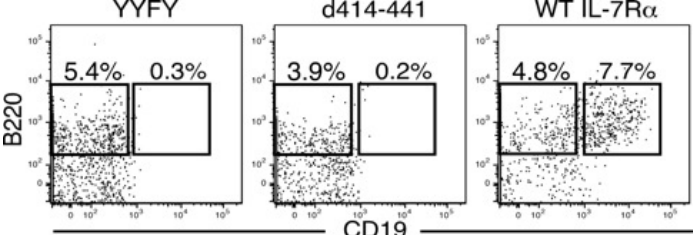
Figure 2. The d414–441 mutant did not support IL-7-mediated stage transition from the pre-proB (B220 + CD19 − ) to proB stage (B220 + CD19 + ) during B-cell development. KLS cells from IL-7Rα −/− bone marrow were infected with retroviruses expressing the YYFY mutant (negative control), d414–441 mutant, or WT IL-7R α (positive control). Two days after infection, green fluorescent protein (GFP)-positive cells were purified by fluorescence-assisted cell sorting (FACS) and cultured on OP9 stromal cell layers in the presence of stem cell factor (SCF), Flt3 ligand, and IL-7 for 6 days. Cells were then stained with anti-B220 and anti-CD19 antibodies and analyzed by FACS.